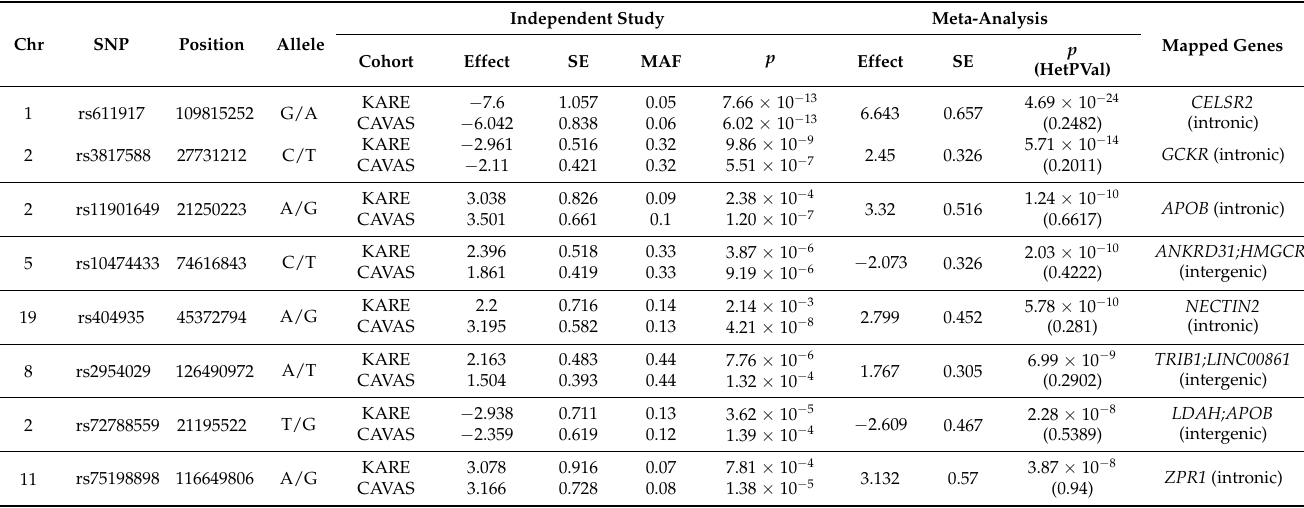
Table 3. Results of GWAS meta-analysis of ApoB (leading SNPs).